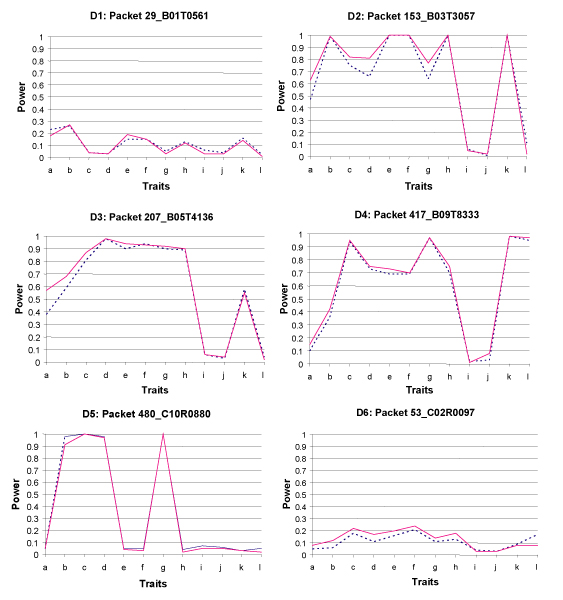
Comparison of power when evaluating multiple phenotypes: HM (solid lines) versus LRM (dotted lines).